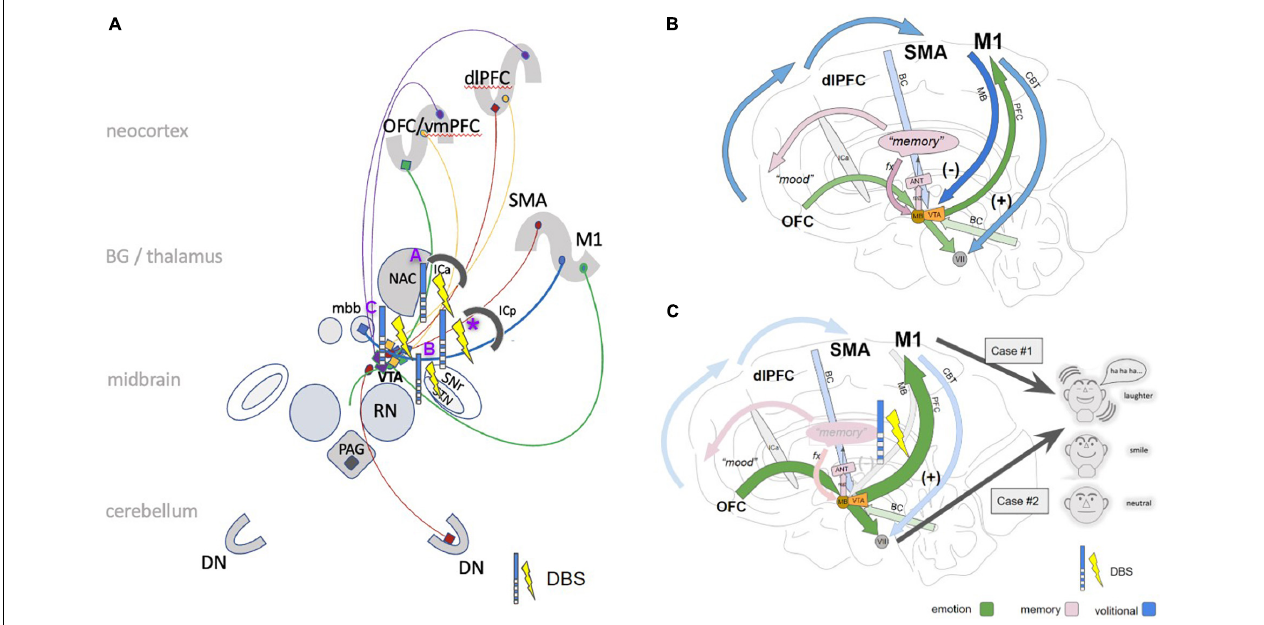
FIGURE 7 | Cartoonistic rendition of subcortical pathways for PAD. (A) The simplified wiring pattern of the different pathways involved: MB (blue), =limiter-pathway, M1 to VTA/mbb complex inhibiting PAD; PFC pathway (green), connects OFC via VTA to M1 and brainstem; red, BC pathway (connects dlPFC via VTA to brainstem and cerebellum). imMFB (purple); connects VTA to OFC and dlPFC (dopaminergic); slMFB (yellow), bidirectional between OFC/dlPFC and VTA. Selected stimulation effects with pathological or induced laughter out of the literature: (A) stimulation in the anterior limb of the internal capsule (Okun et al., 2010; Haq et al., 2011); (B) subthalamic nucleus (STN) DBS (Krack et al., 2001); (C) slMFB DBS in major depression (Schlaepfer et al., 2013; Coenen et al., 2018a); * , this contribution. (B) In the proposed concept the PFC branch (green arrows) of the motorMFB [OFC to M1 and facial nuclei (vii)] serves to immediately display (positive) affect (smiling, laughing). It is regulated, depending on environmental needs via the mamillary body branch (MB, blue arrow) as a “limiter pathway” which inhibits PAD (at the level of mbb/VTA complex). (C) Modulation of MB pathway via DBS leads to a dysfunctional control and thereby to (pathological) laughter (case #1) or simply enhanced